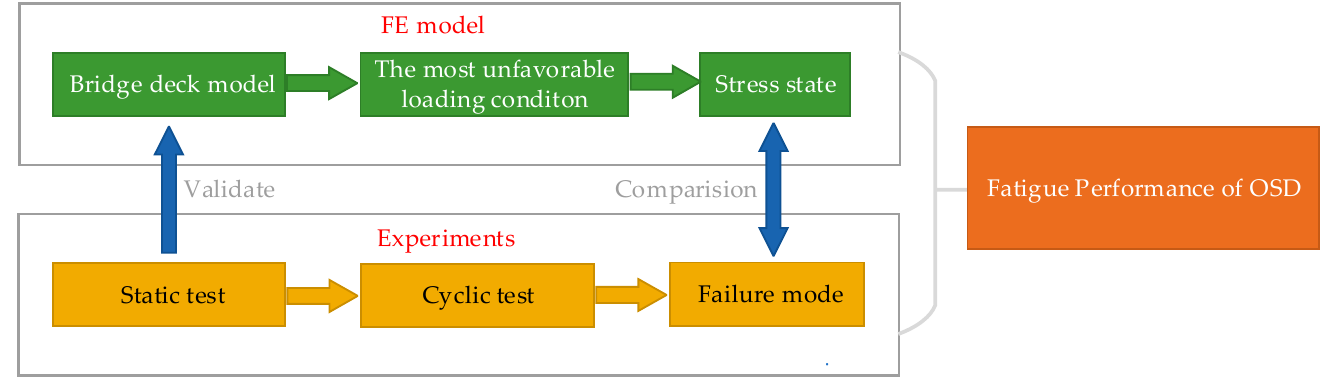
Figure 1. Flow chart.